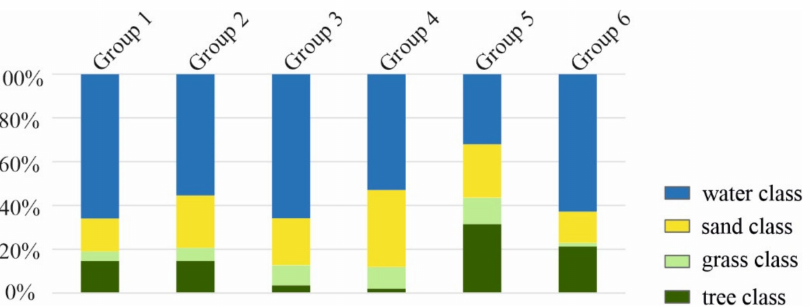
Figure 8. Average land cover areas in Groups 1–6 classified according to Ward’s